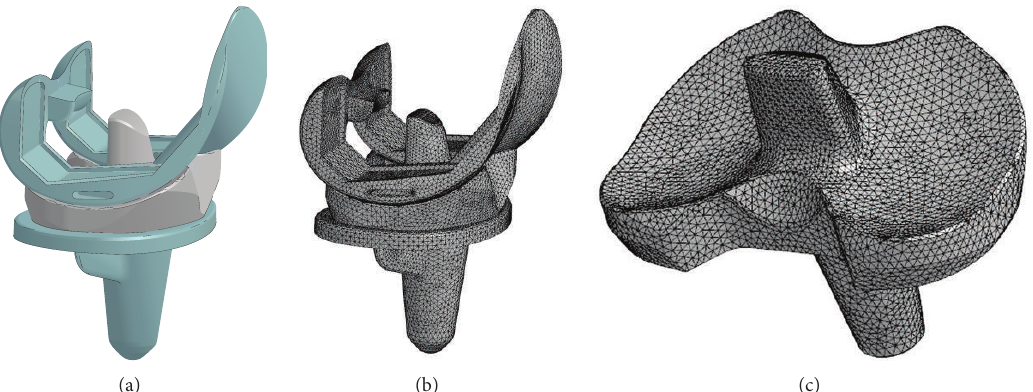
Figure 1: Computational models of mobile bearing type knee prosthesis. (a) CAD model, (b) Mesh model, and (c) Mesh model of tibial insert.